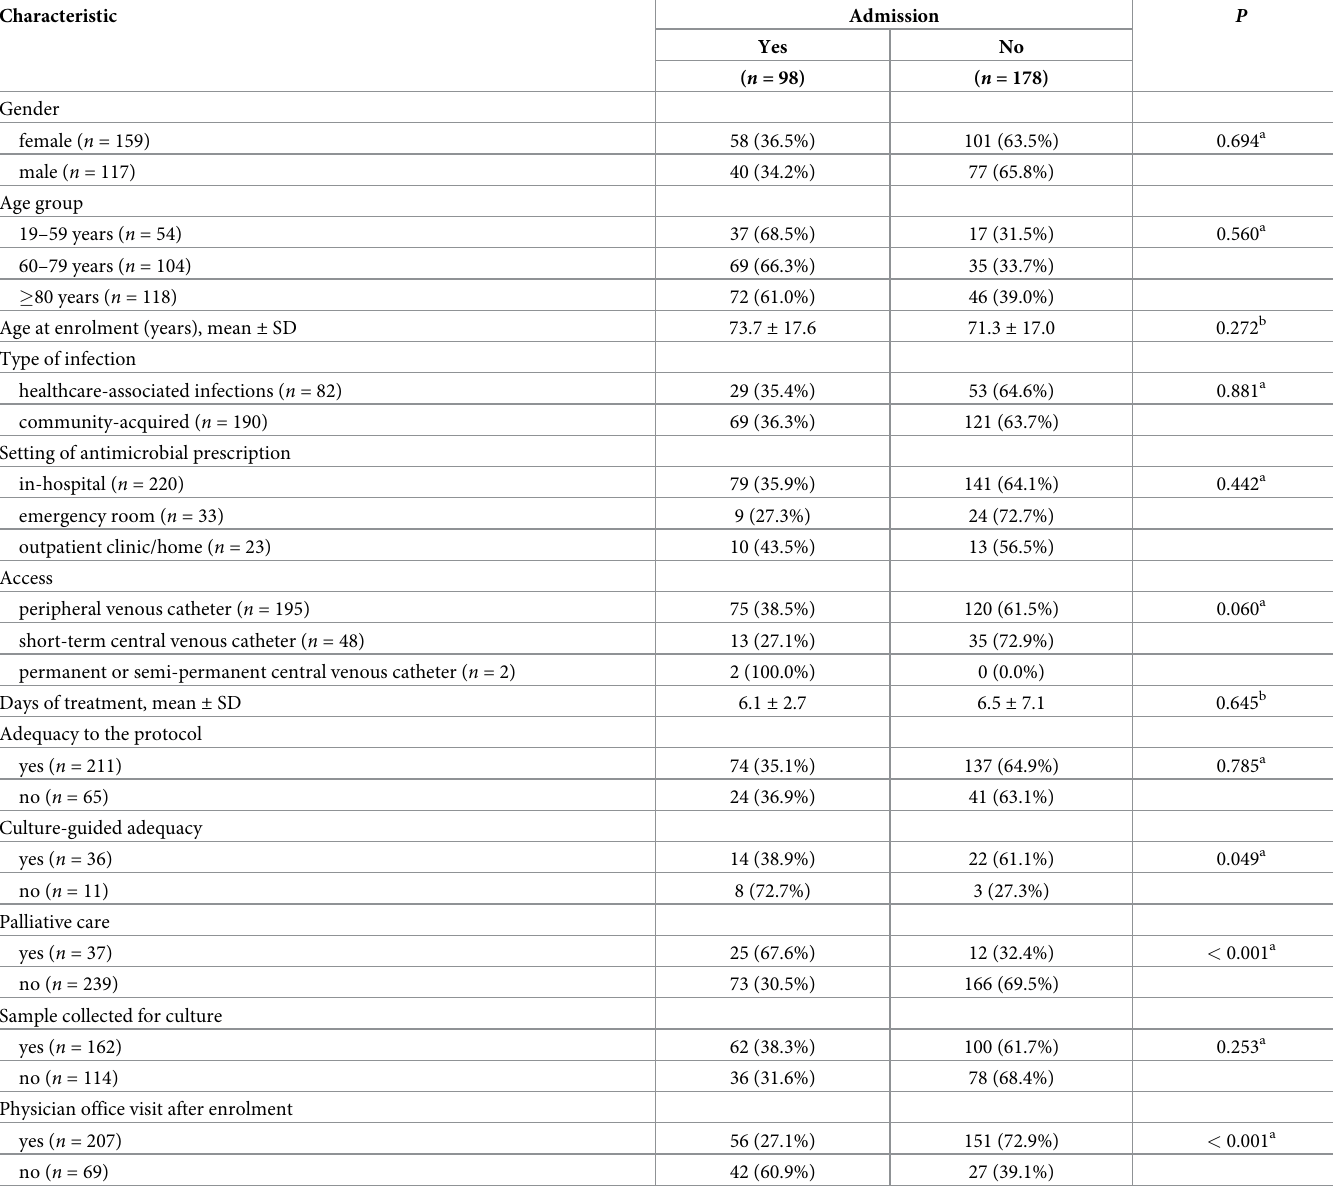
Table 1. Bivariate analysis of factors associated with hospital admission among patients enrolled in an outpatient parenteral antimicrobial therapy program ( n = 276) at facilities within the Santa Helena/Amil UnitedHealth Group network, October 2016 through June 2017.